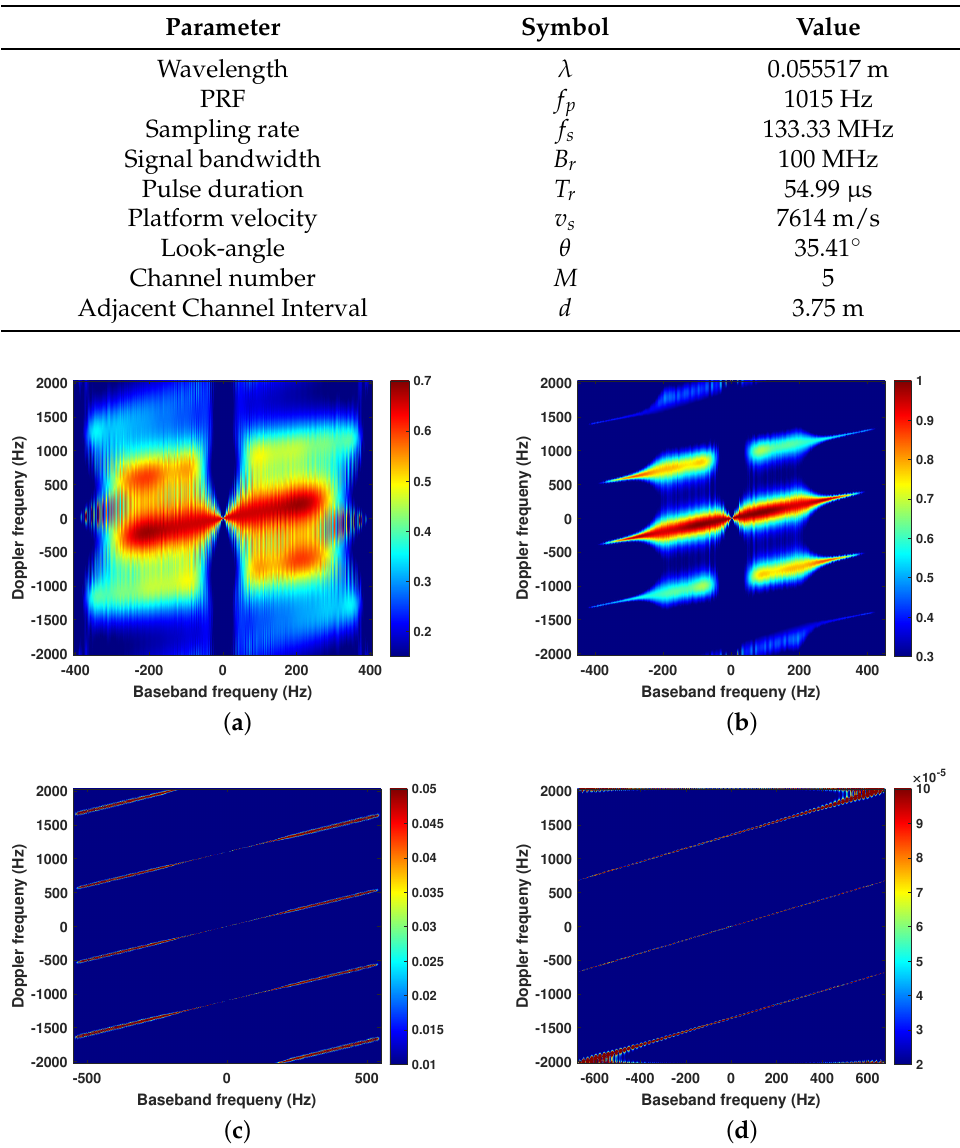
Table 1. Main parameters of the simulated data.